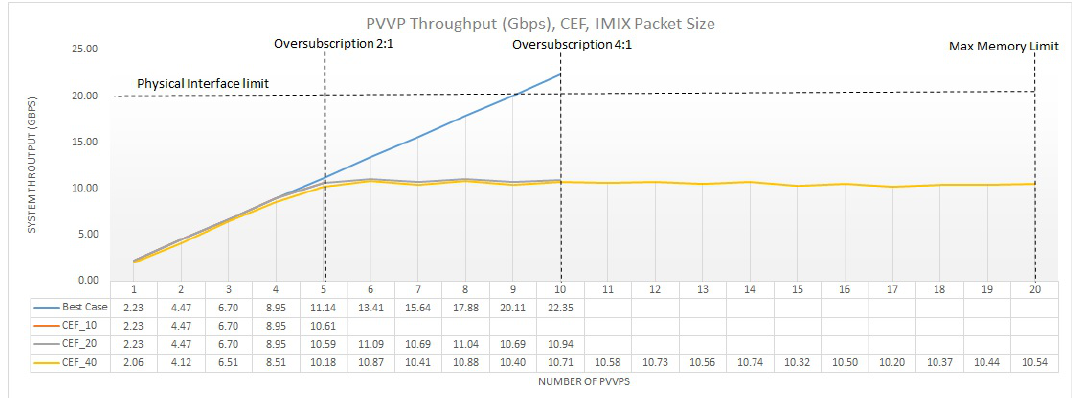
Figure 14. Single-Feature multi-PVVP system throughput with CEF.